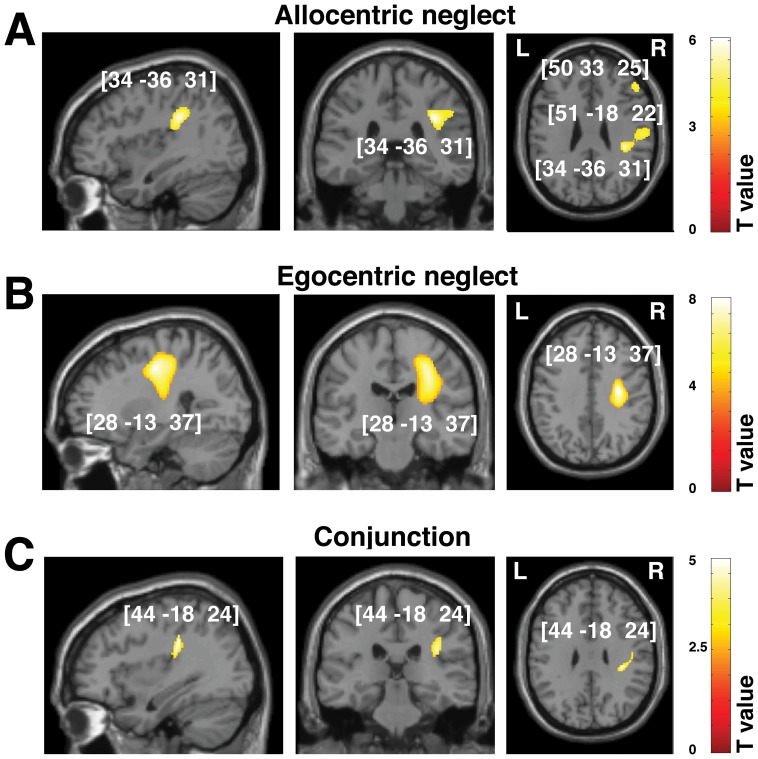
Voxel-wise statistical analysis of white matter damage: allocentric vs. egocentric neglect at the sub-acute phase following stroke.VBM results showing voxels corresponding to white matter damage in (A) left allocentric, (B) left egocentric and (C) both forms of neglect (conjunction analysis). Please note that in A, B and C the lesioned areas are coloured according to their significance level in the VBM analysis, where a brighter colour indicates a higher t-value. The numbers in brackets indicate the peak MNI coordinates.